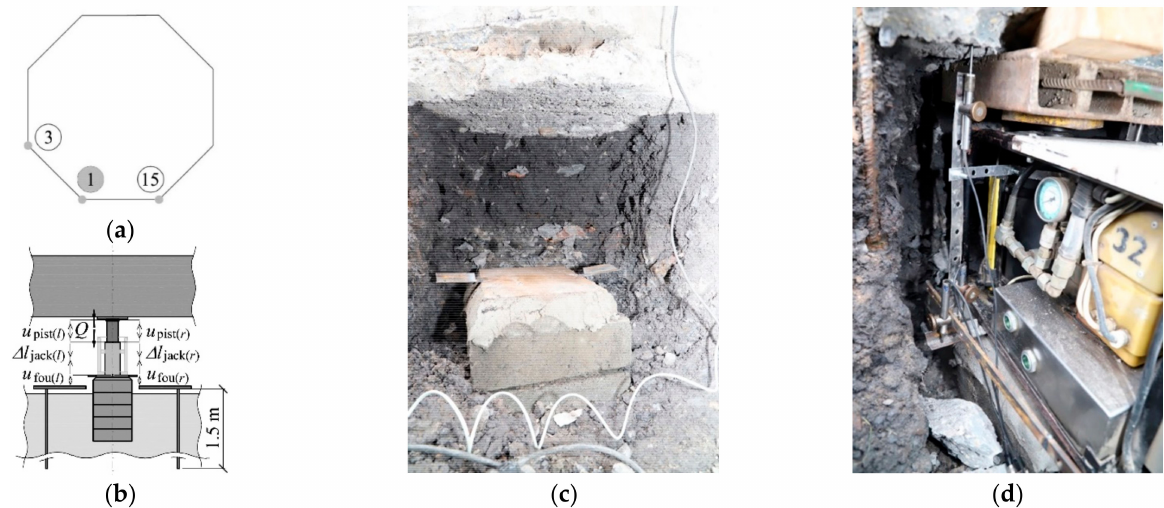
Figure 6. In-situ testing of stiffness k jack , k pist and k fou : ( a ) position of the installed passive jack (1) and active jacks (3, 15); ( b ) plan of measurements (passive jack); ( c ) jack support in the form of a stack of concrete blocks pressed under the foundation slab; ( d ) jack placed on the jack support and prepared for tests.